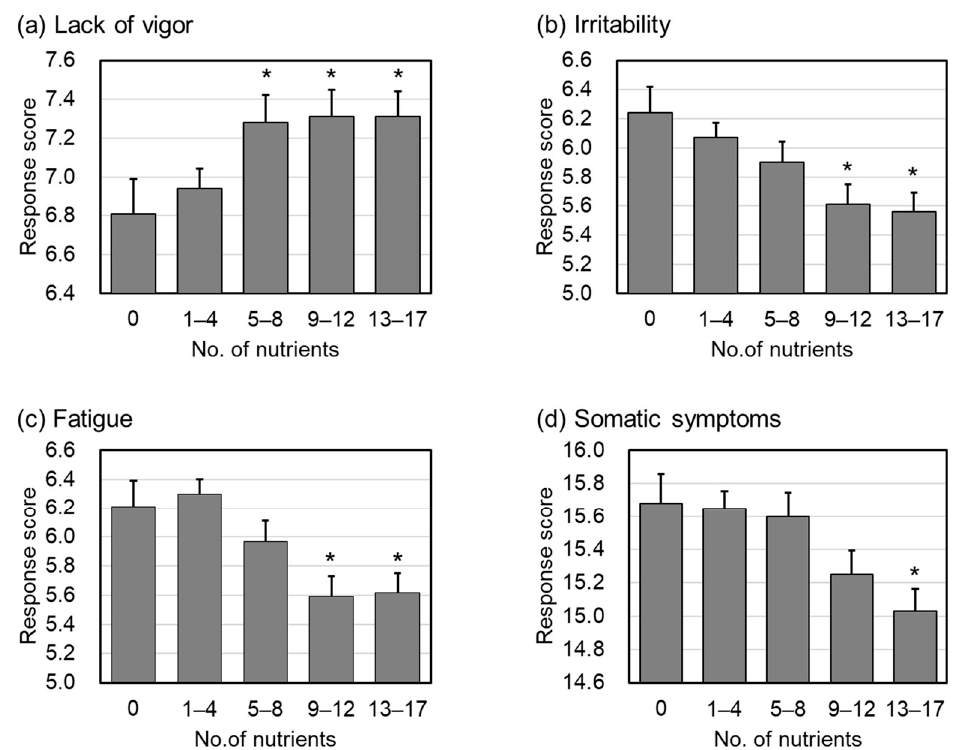
Figure 4. The mean MHC levels in each subgroup. ( a ) Response score (lack of vigor), ( b ) response score (irritability), ( c ) response score (fatigue), ( d ) response score (somatic symptoms). Bar charts are shown as the mean ± standard error. Asterisks show significant difference compared with the 0N group. As for the lack of vigor, a higher response score indicates better psychosomatic status, and a lower response score indicates better status for irritability, fatigue, and somatic complaints.